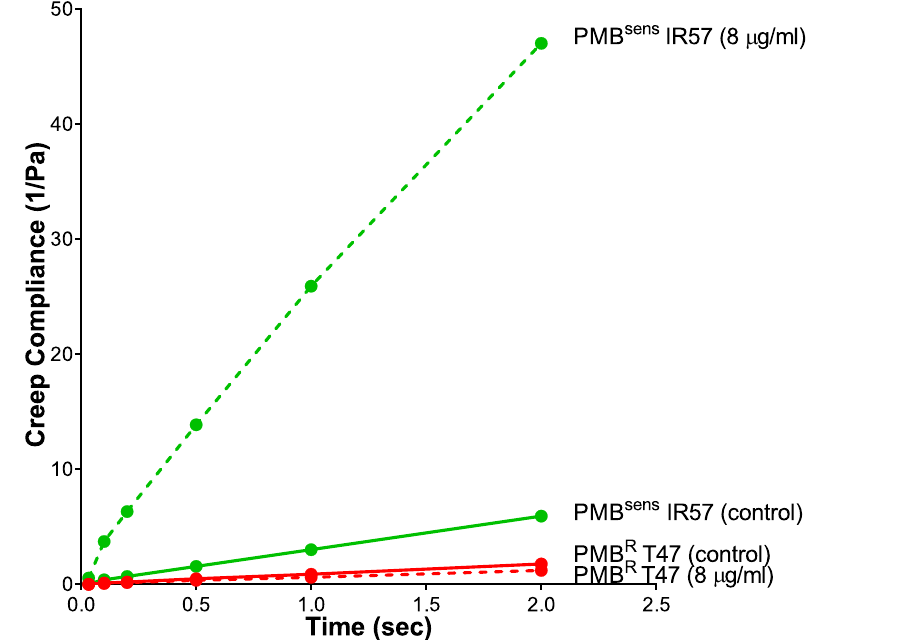
Fig. 7 Creep compliance of PMB Sens E. coli IR57 and PMB R E. coli PN47 bio fi lm structures ± Polymyxin B treatment. Creep compliance ( J ( t )) of polymyxin B (PMB, 8 µg/ml) treated (dashed lines) and untreated control (solid lines) E. coli IR57 and PN47 bio fi lms (measured using ensemble mean square displacement <MSD> versus time of 200 nm negatively charged carboxylate-modi fi ed Fluo Sphere ®